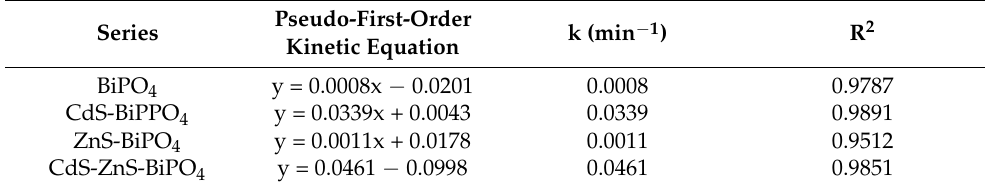
Table 2. Pseudo-first-order rate constants for photocatalytic MB degradation by the prepared com- posites under visible light irradiation. Series